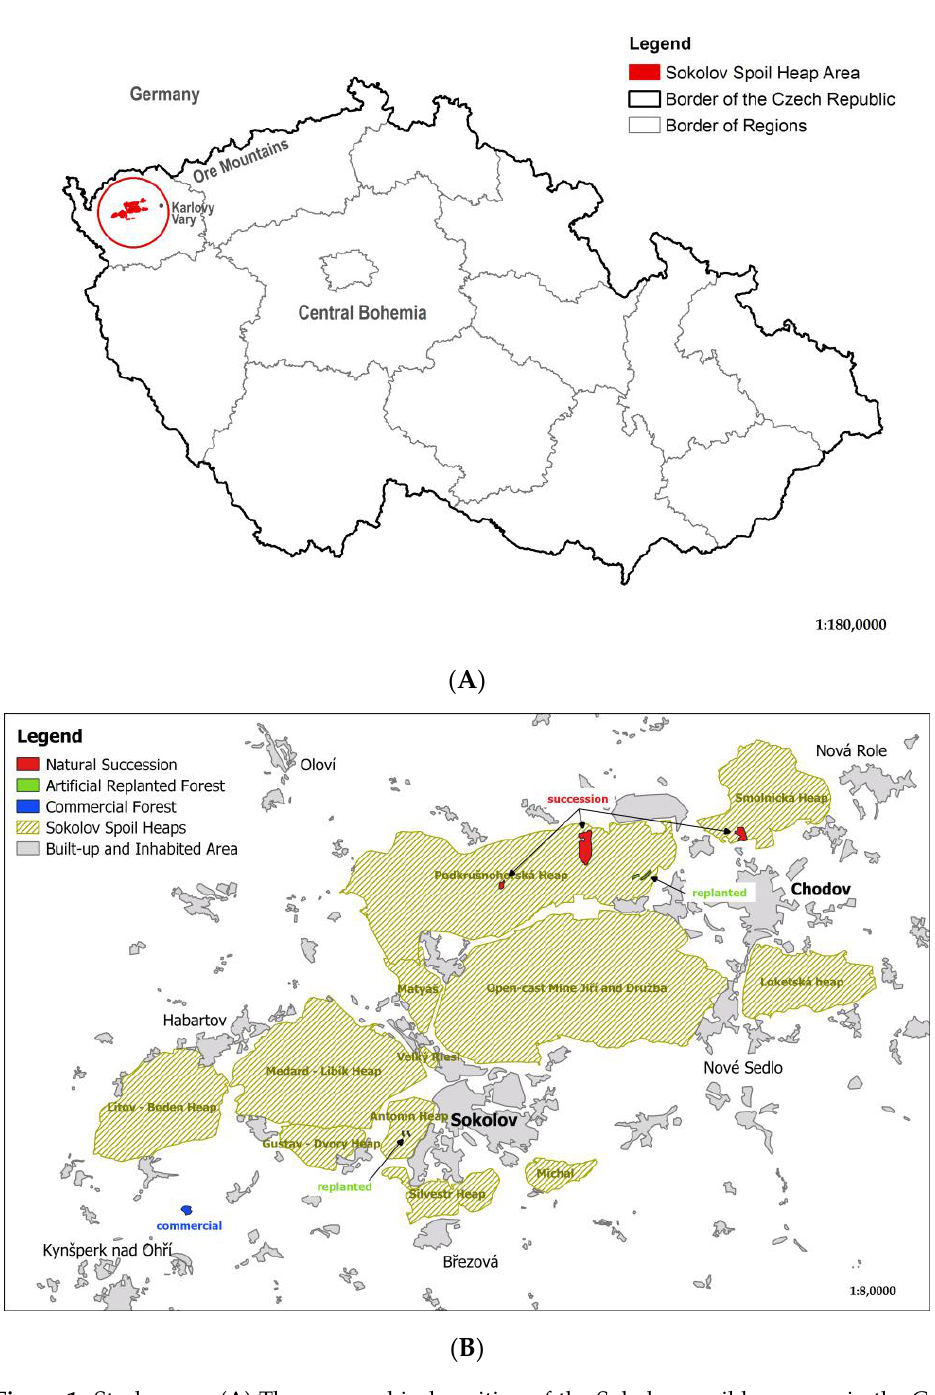
Figure 1. Study area. ( A ) The geographical position of the Sokolov spoil heap area in the Czech Republic; ( B ) the geographical location of individual spoil heaps and investigated sites of forest stands in the Sokolov